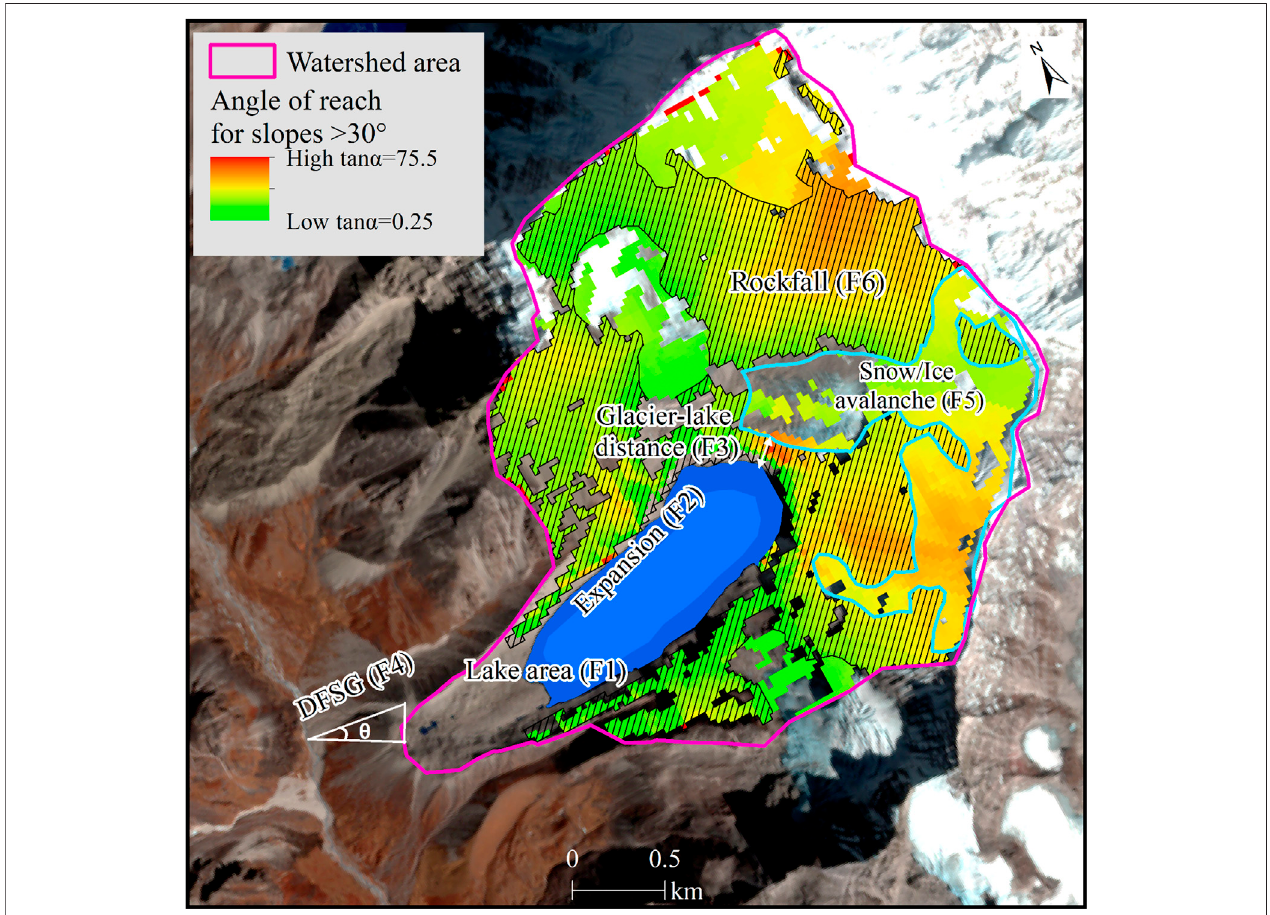
FIGURE4| TheconceptofsixfactorsconsideredintheGLOFsusceptibilityassessment:anexamplefromSouthChamlangTsho.Here, θ representsthedamfront slope gradient and the value of DFSG for rock dammed glacial lakes is zero. The background is a false-colour composite Sentinel-2 image.